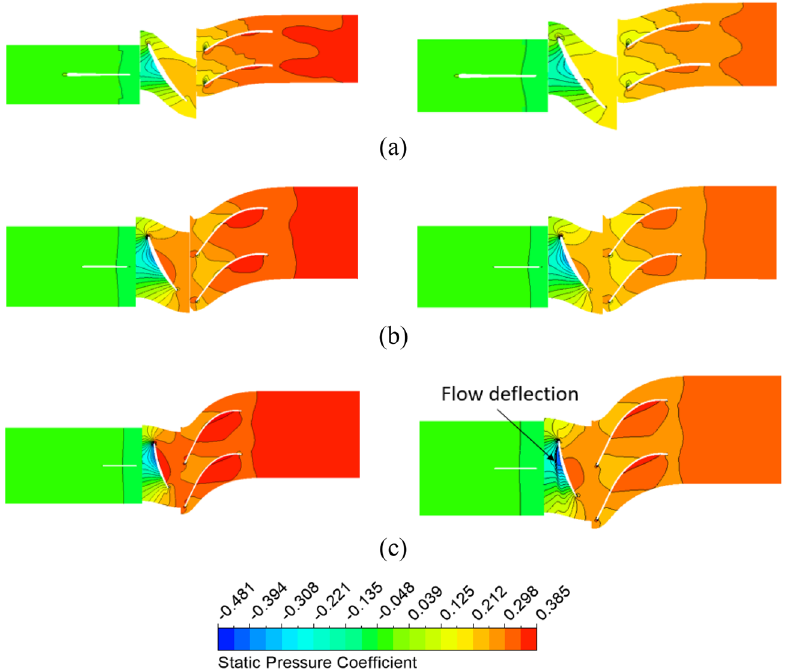
Figure 18. Static pressure distribution in reference case (left) and impeller’ gap case (right). ( a ) 5% span, ( b ) 50% span, and ( c ) 95%